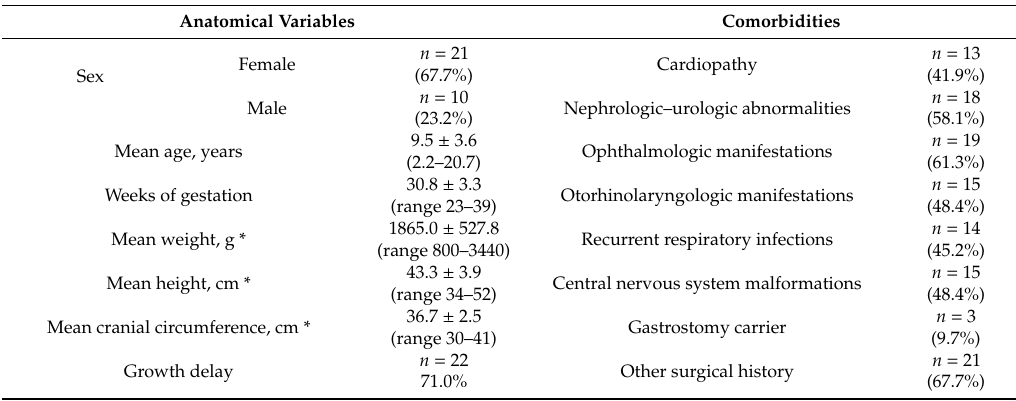
Table 1. Anatomical characteristics and clinical findings / comorbidities in study-group patients with Wolf-Hirschhorn syndrome ( n =